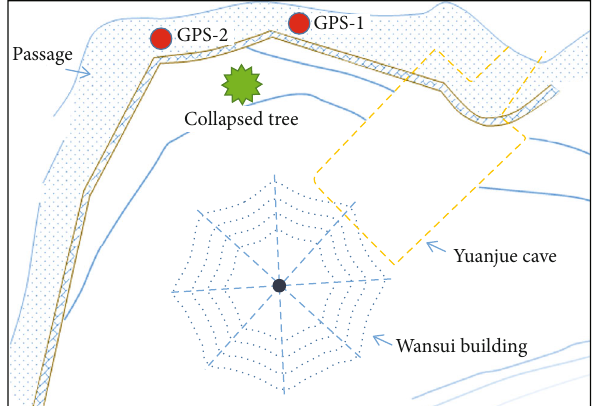
Figure 7: Monitoring site